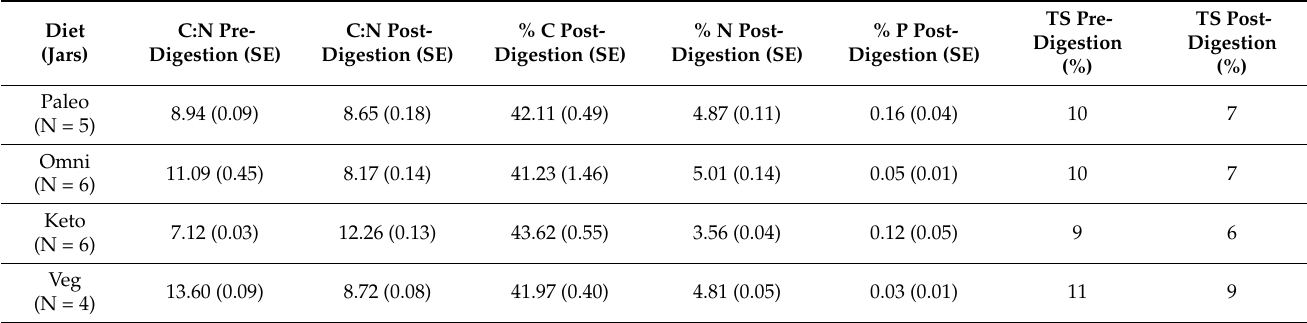
Table 4. Digestate characteristics from different food waste